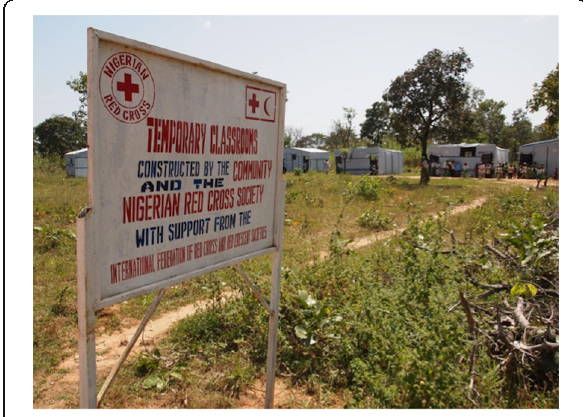
Figure 4 Temporary classrooms set up by the Nigerian Red Cross to cater for the refugee crisis in the KGR